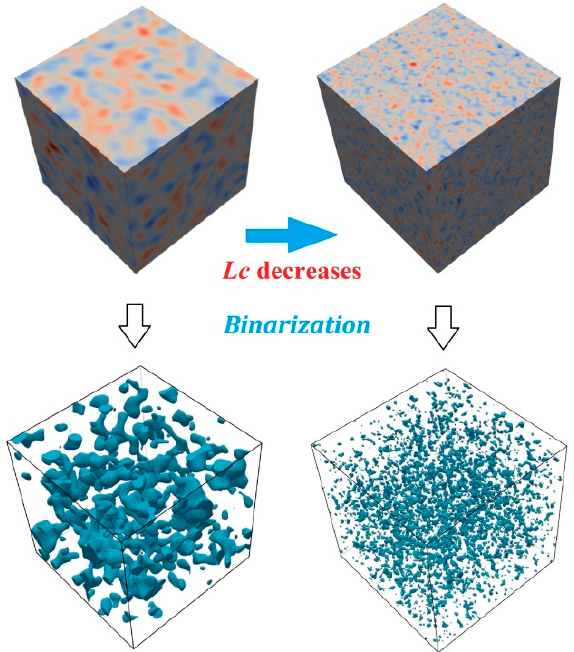
Figure 5. Influence of Lc on the appearance of the random field and the two-phase field.